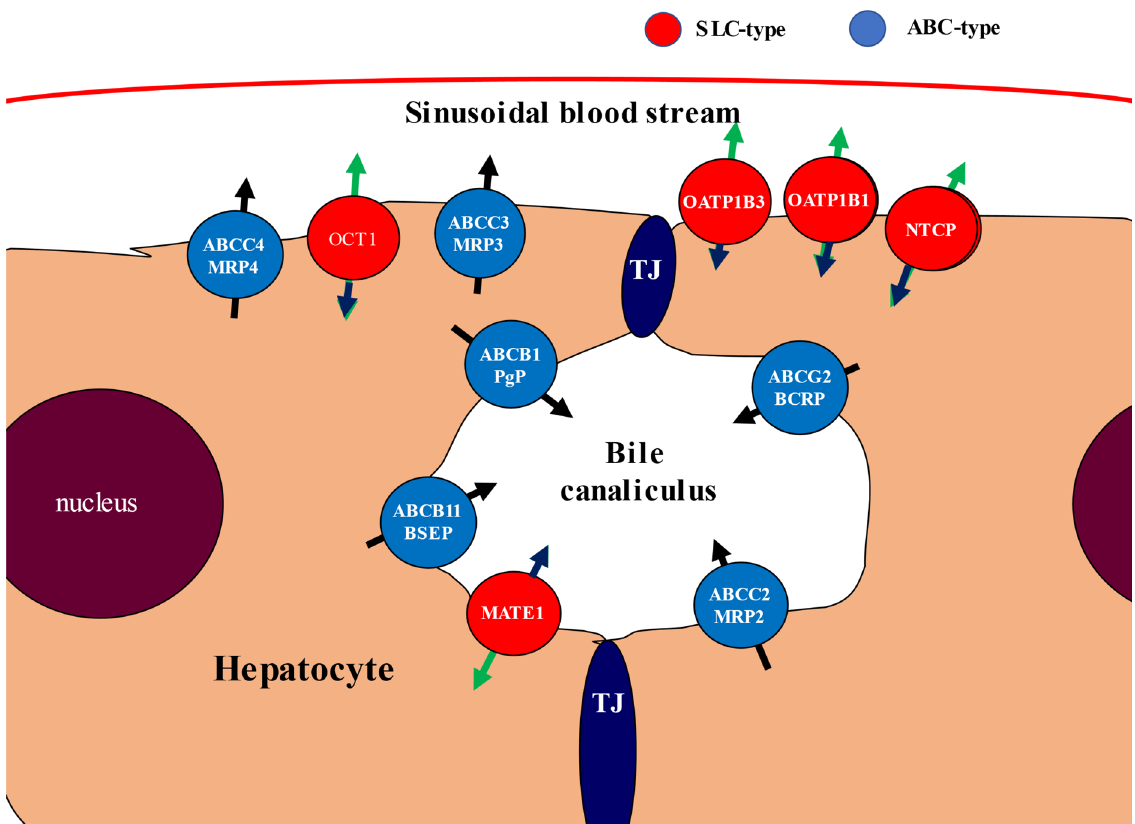
Figure 1. Schematic presentation of the localization and transport directions of the hepatocyte transporters examined in the present work. SLC type transporters are colored red, ABC type transporters are blue, TJ: tight